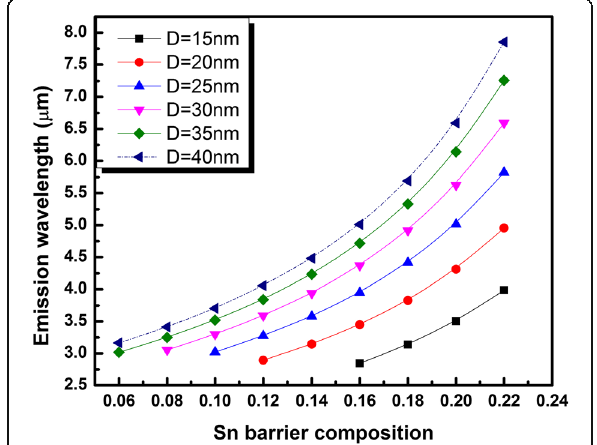
Fig. 5 Room temperature ground state emission wavelength from direct bandgap Ge 0.72 Sn 0.28 QD as a function of size and Sn composition of the Ge 0.65- xb Si 0.35 Sn xb surrounding